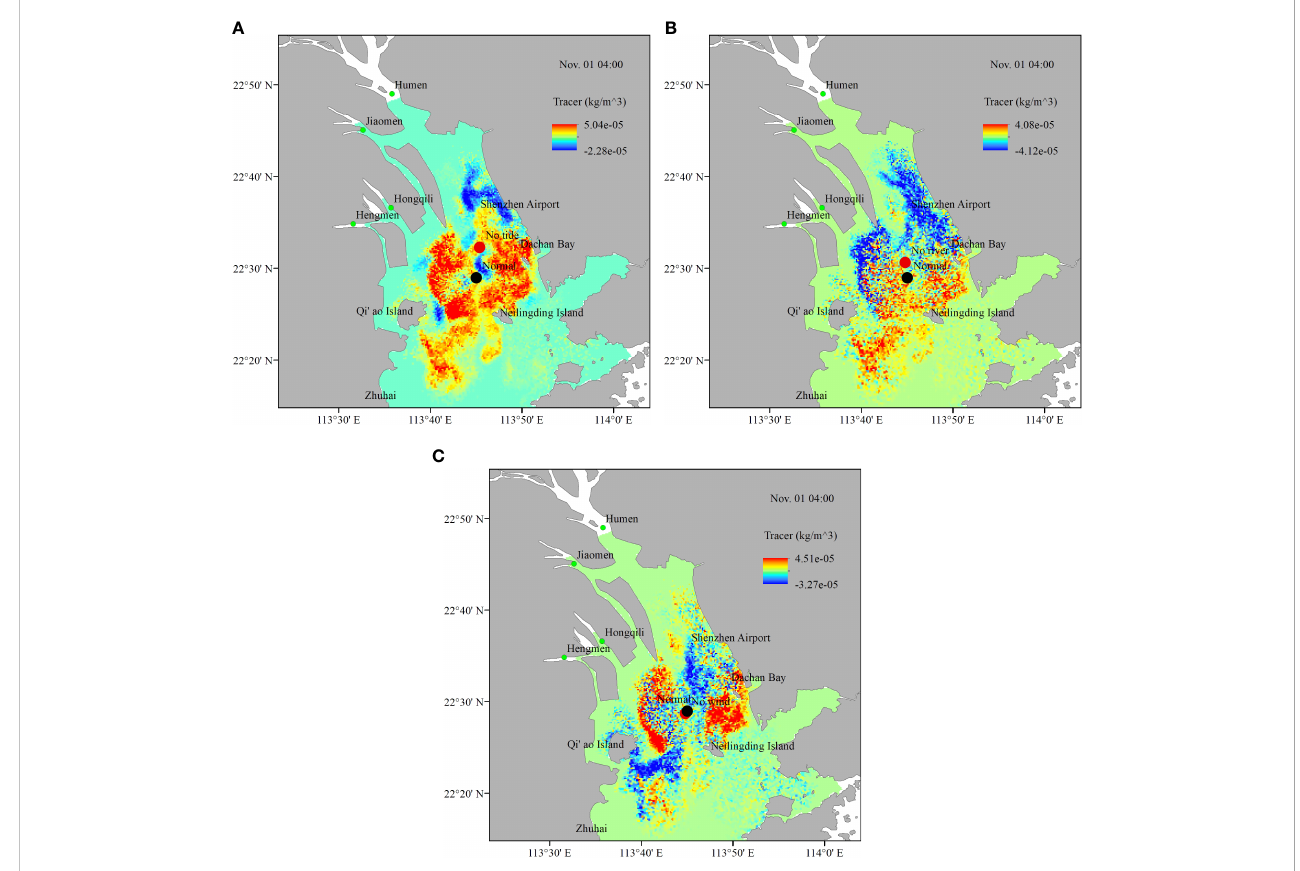
FIGURE 8 The relative differences in the particles cloud distribution between the experiments. (A) Experiment 1 (Normal) and 2 (No tide); (B) Experiment 1 (Normal) and 3 (No runoff); (C) Experiment 1 (Normal) and 4 (No wind).